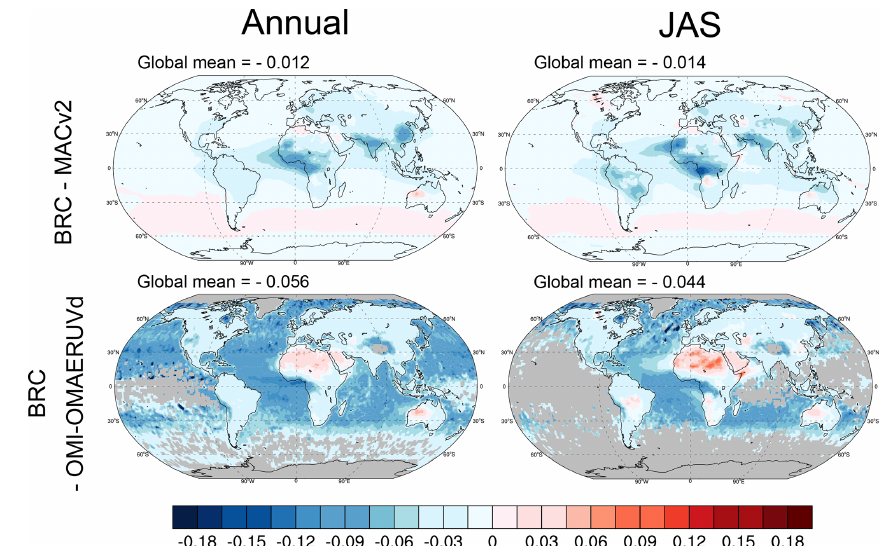
Figure A7. Same as Fig. A3 but for the AAOD (350nm; see Tables 2 and 3 for details).